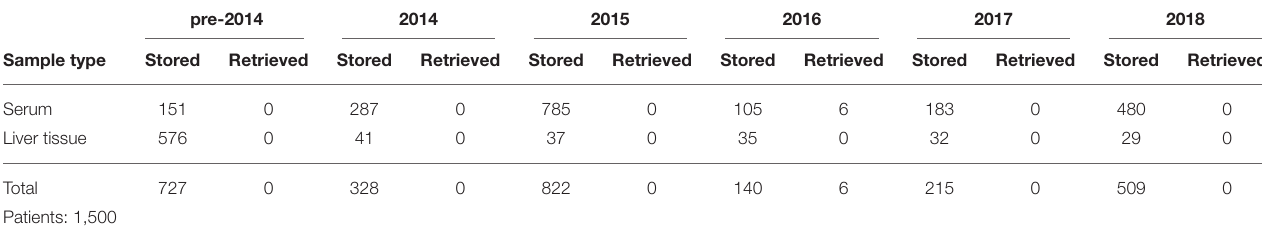
TABLE 1b | Hospital-based sampling (presumed consent/leftover samples).